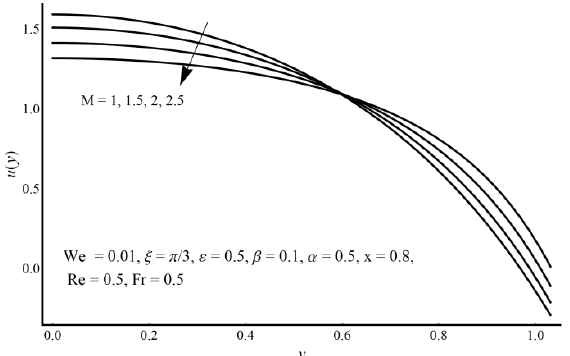
Figure 2. The velocity profile for different values of variable We.